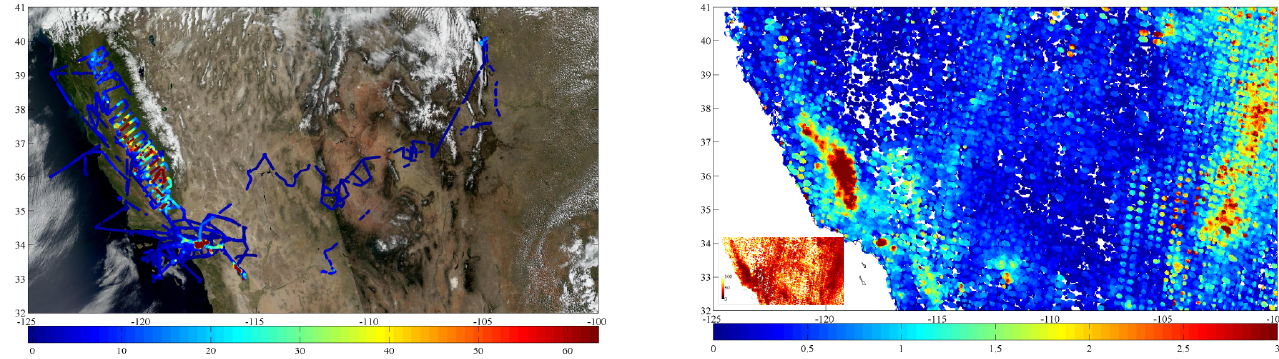
Figure 6. NH 3 distribution measured from CIMS instrument on-board NOAA WP-3D aircraft (left, ppbv) and IASI satellite (right, moleccm − 2 ) averaged for the flight period of the CalNex campaign (from 30 April 2010 to 24 June 2010). Averaged relative retrieval error (%) of the IASI-NH 3 columns are presented as inset in the lower left corner of right panel. Only column means associated with weighted relative retrieval errors below 100% are shown.